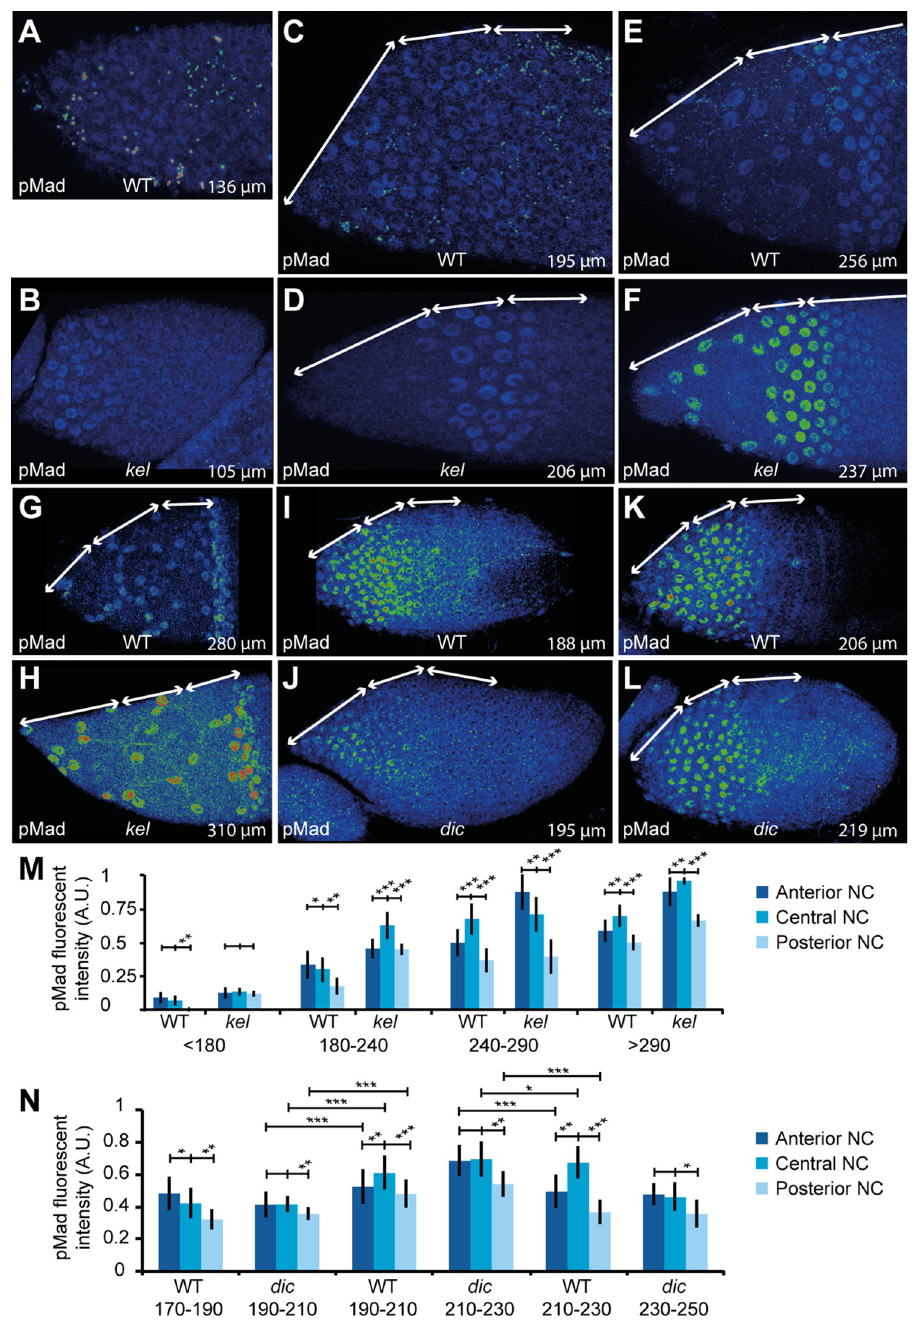
Fig 4. The pressure gradient controls the timing of the TGF β pathway. (A-L) Projections of the sections displaying pMad fluorescence in the StC in WT follicles (A, C, E, G, I, K), kel follicles (B, D, F, H), or dic follicles (J, L). To allow comparison of expression level between WT and mutants, the images were treated identically for each stage, but differently between stages (enabling comparison between A and B; C and D; E and F; J and K; L and M); (G) and (H) cannot be compared, as intensity levels in (H) were too high to be enhanced as for (G). The double white arrows on each follicle indicate areas above the anterior, central, and posterior NC. The total length of the follicle is indicated. (M, N) Quantification of pMad fluorescence in WT and kel follicles (M) or in WT and dic follicles (N) in function of follicle length and stage (see S5 Fig) ( n > 15 nuclei per region). Data for graphs (M) and (N) can be found in the S1 Data file. A.U., arbitrary units; dic , dicephalic ; kel , kelch ; NC, nurse cell; pMad, phosphorylated form of Mad; WT, wild type.